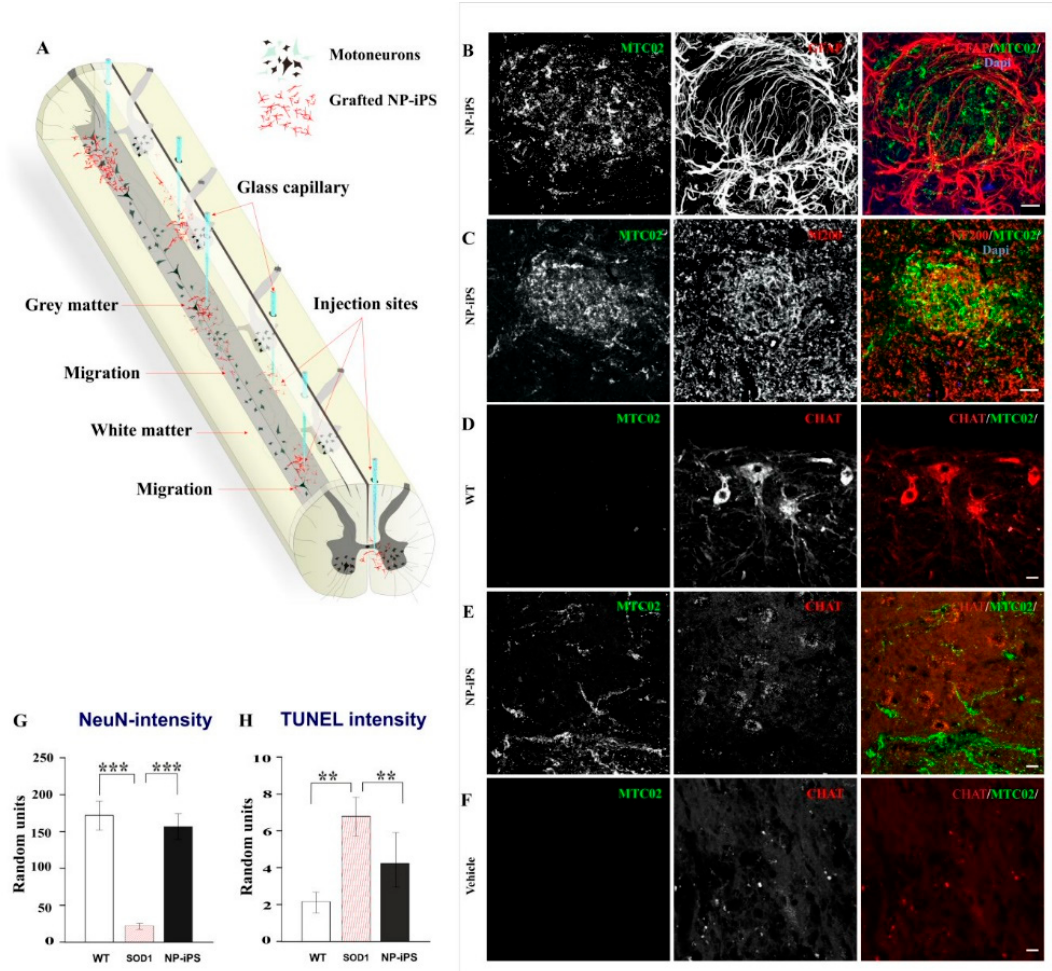
Figure 4. Survival and engraftment of NP-iPS. Schematic diagram shows a map of intraspinal injection sites (via the glass capillary tubes) and distribution of the grafted cells within the spinal cord ( A ). Intraspinally transplanted NP-iPS engrafted into the host tissue at the site of injection ( B ), Engrafted cells also preserved the expression of host neurofilament ( C ). Compared to WT rats ( D ), cell-treated animals ( E ) had weaker acetylcholine transferase (CHAT) staining, even though NP-iPS engrafted in the close vicinity to host MNs ( E ); however, NP-iPS-treated rats still maintained CHAT-positive cells ( E ) compared with vehicle-treated animals, where the CHAT staining was almost undetectable ( F ). A neuroprotective effect evaluated by NeuN fluorescence intensity revealed a significantly higher fluorescence in the ventral horns of NP-iPS-treated superoxide dismutase (SOD1)-rats compared with the vehicle-treated SOD1 littermates ( G ). TUNEL staining confirmed less apoptosis in NP-iPS-treated SOD1-rats compared with the vehicle-treated SOD1 littermates ( H ). Cell nuclei were visualized with 4 ′ ,6-diamidino-2-phenylindole (DAPI) staining. Differences in the groups were analyzed by one-way ANOVA, p < 0.01 (**), p < 0.001 (***). Scale bars = 20 µm.